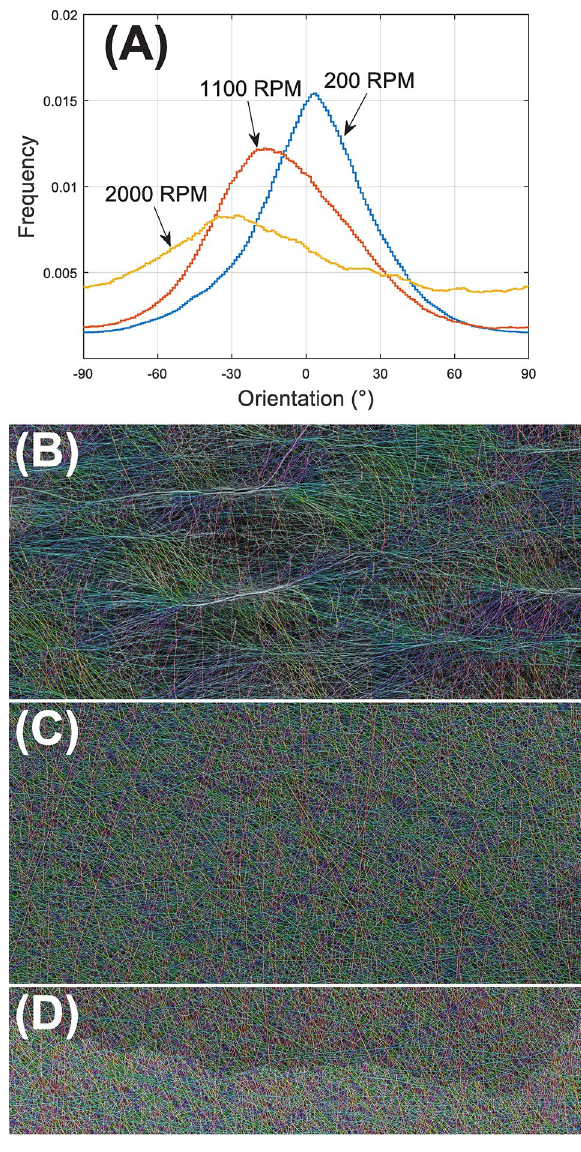
Fig 9. (A) Distribution of fiber orientations across axial (0˚) to azimuthal ( ± 90˚) directions at different RPMs. Orientation-based colorization of SEM images taken from the center of (B) 200, (C) 1100, and (D) 2000 RPM depositions. To achieve better statistical representation, each image is stitched from 50 individual SEM images and covers a net area > 2,000,000 μ m2. In all three images (B-D), the direction of mandrel rotation (azimuthal, ± 90˚) is in the vertical direction. Original (un-colorized) images and colormap are available in S4 and S5 Figs in S1